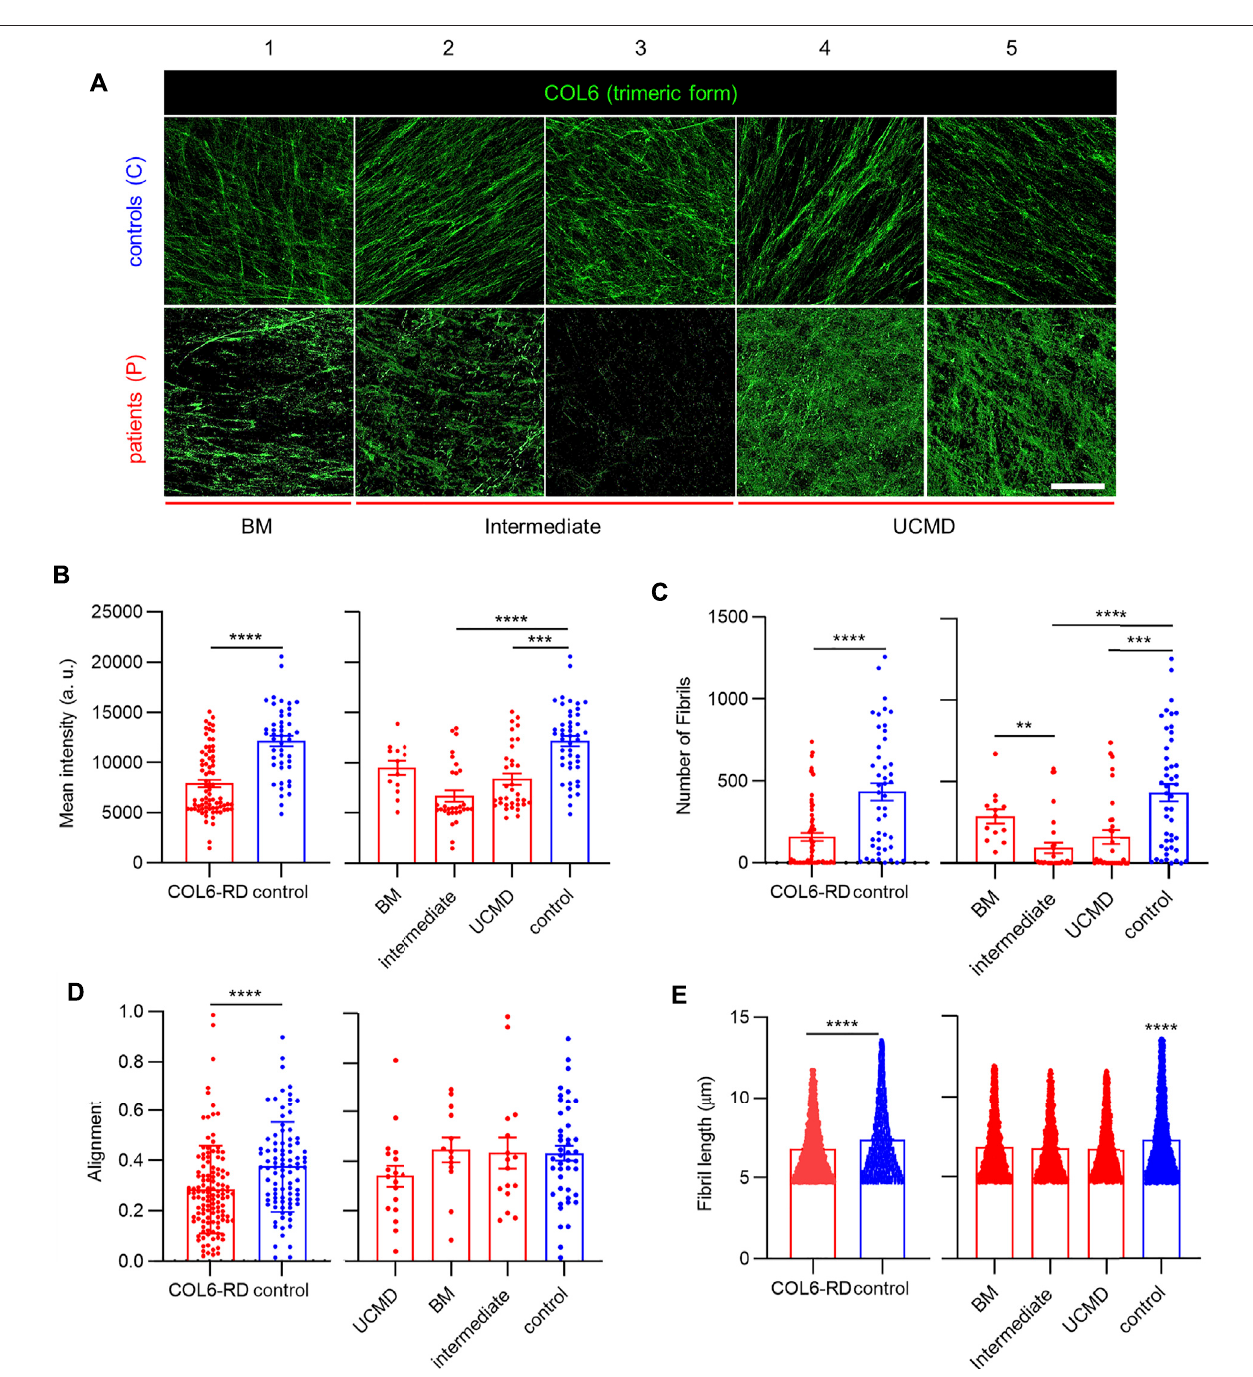
FIGURE 2 | COL6 deposition in the CDMs. (A) Representative confocal images of COL6 in the CDMs obtained from patients with COL6-RDs and healthy donors (controls). Scale bar: 50 µm. (B) Quanti fi cation of the mean fl uorescence intensity of COL6. 13 ≥ n ≥ 46, (C) Quanti fi cation of the number of fi brils. 13 ≥ n ≥ 46, (D) fi bril alignment. 13 ≥ n ≥ 44, and (E) fi bril length. 3413 ≥ n ≥ 18011, in CDMs through computational analysis, showing a signi fi cant decrease for patients with COL6-RDs. Threemicroscope fi eldsofviewwereanalyzedperreplicateofatleast3replicatesperdonor.Resultsarethemean±SEM.** p < 0.01,*** p < 0.001,**** p < 0.0001. “ a.u. ” : arbitrary